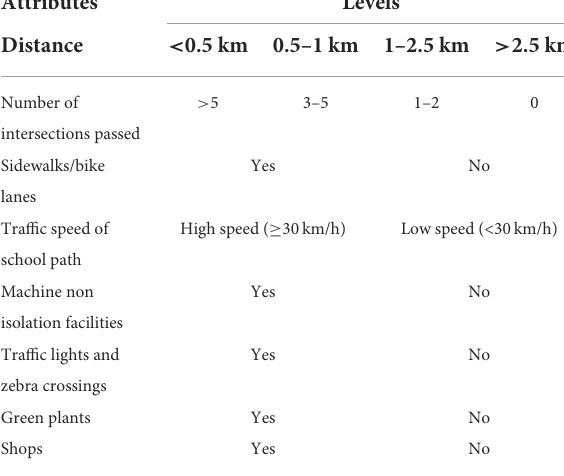
TABLE 1 Attribute levels.